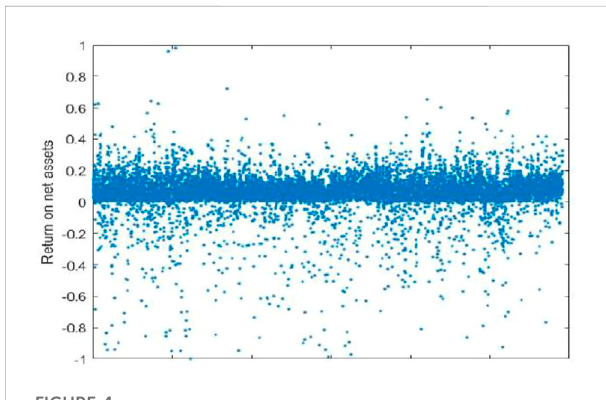
FIGURE 4 Scatter chart of return on equity scaling results.